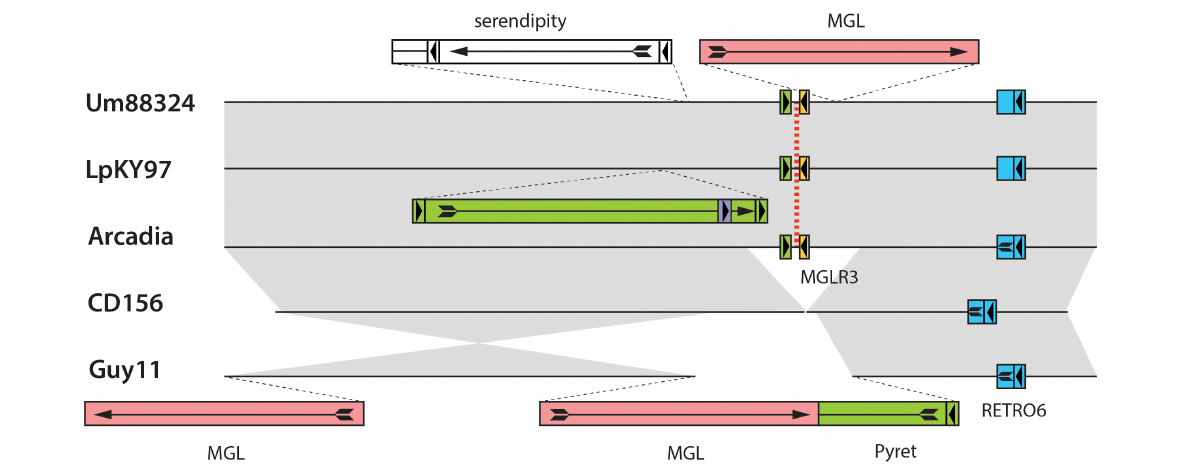
FIGURE 4 | Chromosomal rearrangements at a MoTeR relic locus. Shown are alignments surrounding a MoTeR relic locus at position on LpKY97 chromosome 3. Strain names are listed on the left. The position of the relic is indicated with a red dotted line. Transposon insertions are shown as colored rectangles and their orientations are indicated with arrows. At least one copy of each element is named. Full-length long terminal repeat (LTR) retrotransposons are represented as colored boxes with a complete arrow (head + tail) representing the gag-pol open reading frame (ORF arrow). Smaller, flanking boxes with arrowheads represent the LTRs. Solo-LTRs are represented as appropriately colored small boxes with directional arrowheads. Truncated elements are shown missing LTRs and truncated ORF arrows. Full-length copies of the LINE-type MGL element are represented as plain red rectangles with a complete ORF arrow showing the reverse transcriptase open reading frame. Gray shading is used to connect alignable